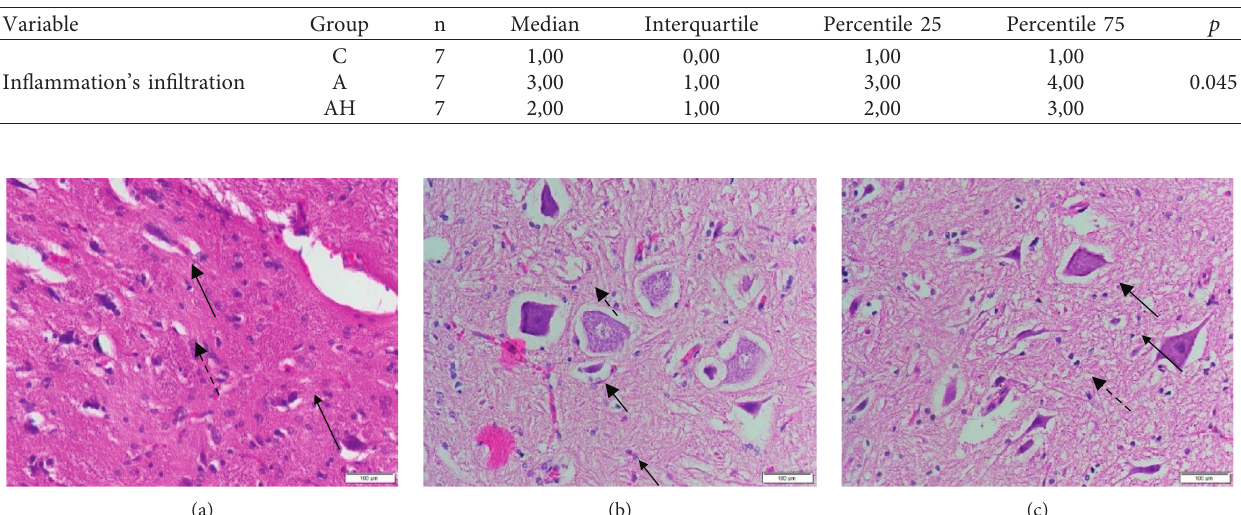
Table 3: Descriptive data of axon degeneration’s score of the rabbit model.